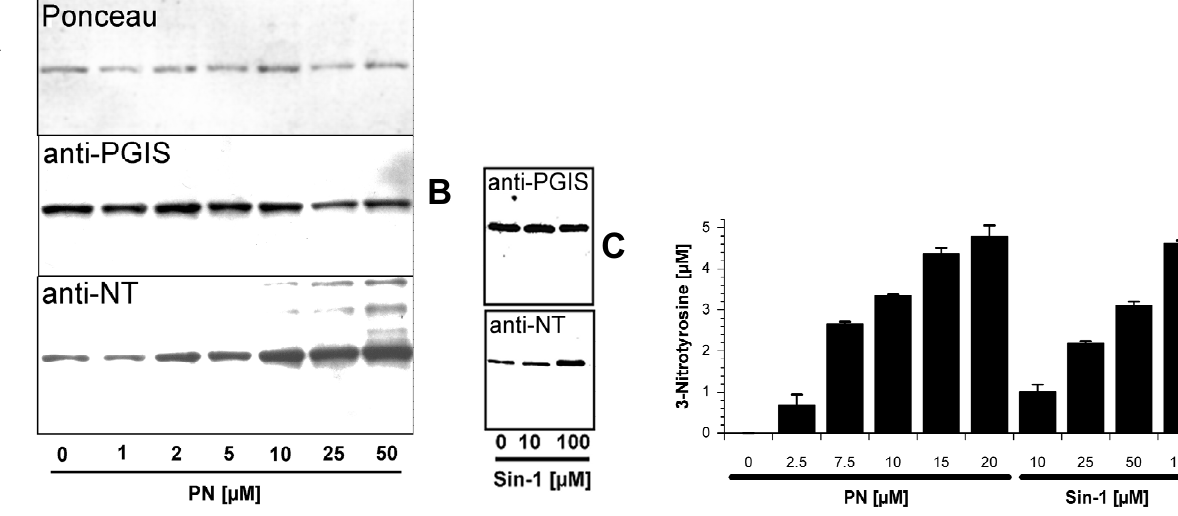
Figure 1. Detection and quantification of tyrosine nitration in human prostacyclin synthase (PGIS). ( A ) Western blot analysis of microsomal fractions (1 mg/mL total protein) containing 200 μ g/mg PGIS which were treated with increasing amounts of authentic peroxynitrite (PN, 0–50 μ M) or ( B ) Sin-1 (0–100 μ M). The figures show staining with Ponceau S, with a polyclonal anti-PGIS antibody and with a monoclonal anti-3-nitrotyrosine antibody; ( C ) HPLC-based quantification of 3-nitrotyrosine in microsomal fractions (1 mg/mL) containing 200 μ g/mg PGIS which were treated with increasing amounts of authentic peroxynitrite (PN, 0–20 μ M) or peroxynitrite generated in situ by Sin-1 (10–100 μ M). Data are means ± SEM ( C ) or representative of three independent experiments ( A and B